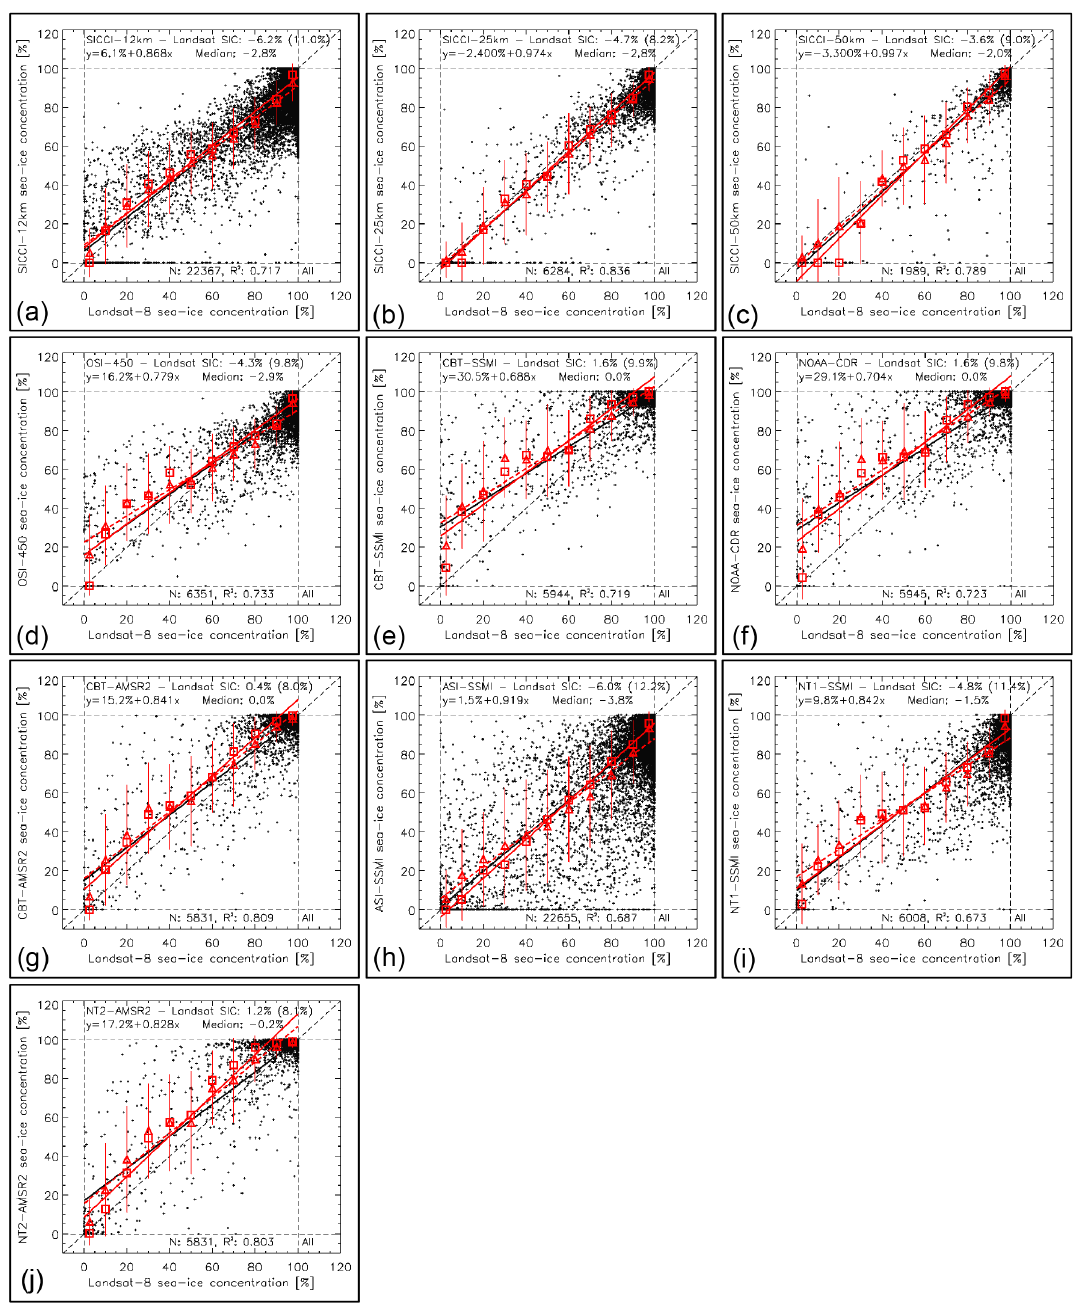
Figure 3. Scatterplots of PMW SIC ( y axis) versus Landsat SIC ( x axis) for all 10 products for mixed first-year–multiyear or multiyear ice cases from 2013 to 2015 in the Northern Hemisphere (Landsat-8). See Fig. 2 for a description of symbols, lines, and